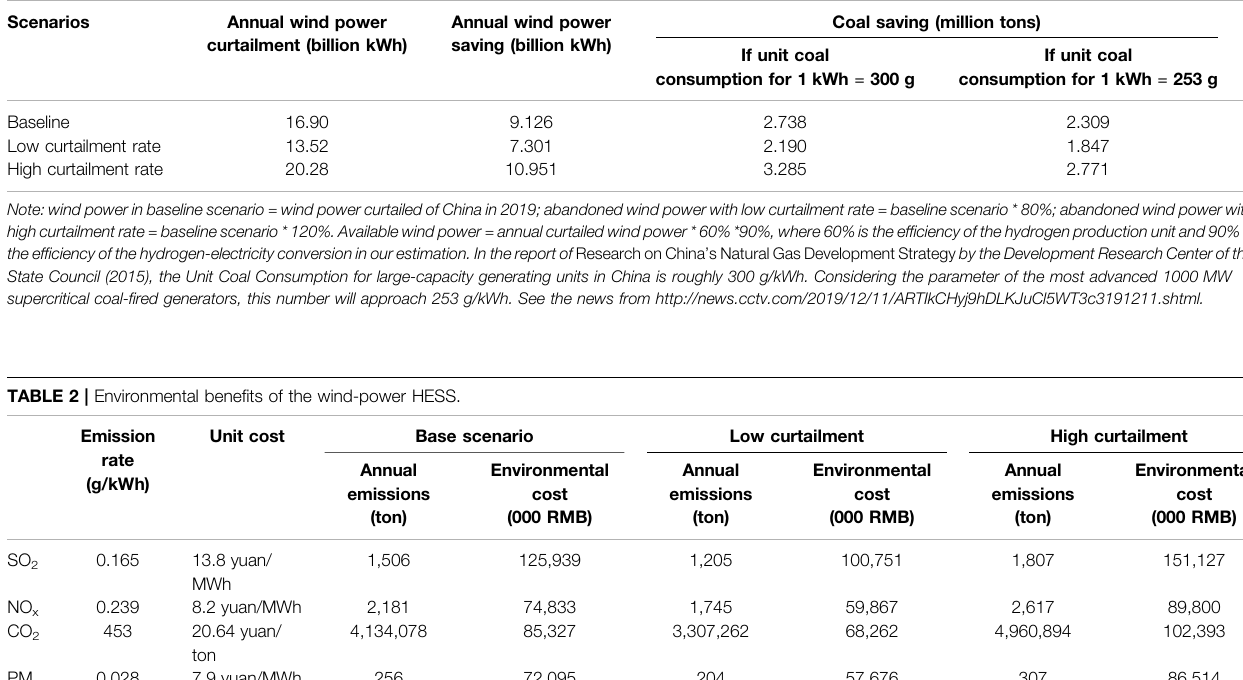
TABLE 1 | Coal consumption savings of wind-power